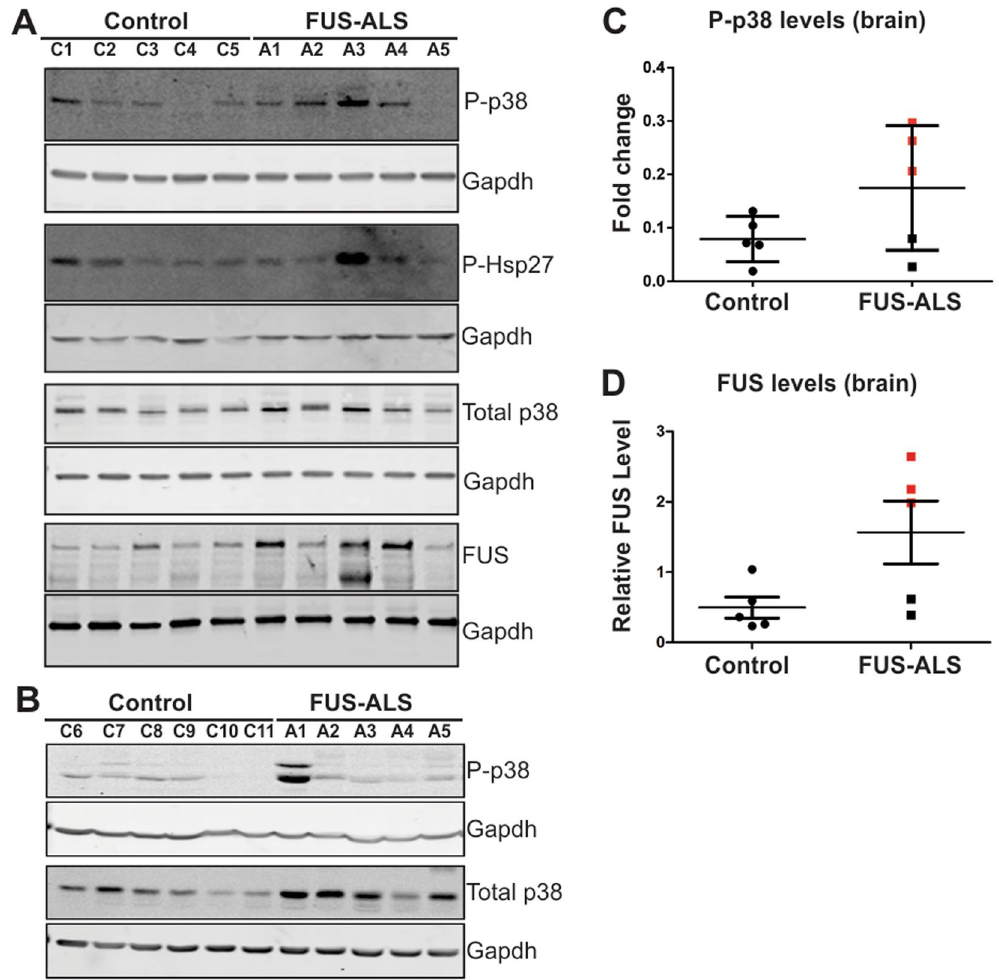
Figure 5. Increased levels of phosphorylated p38 MAPK in human post-mortem CNS tissues derived from individuals with ALS-FUS. Immunoblot analysis of frozen post-mortem brain ( A ) and spinal cord ( B ) tissues derived from non-disease control (C1-C11) and ALS individuals harboring FUS mutations (A1-R521G; A2- H517Q; A3- ex14del; A4-P525L and A5- bp1408del) with the indicated antibodies (see Supplemental Table S2 for detailed patient information). ( C ) Quantification of phosphorylated (active) p38 (p-p38) by immunoblot analysis revealed higher levels of p-p38 MAPK in ALS cases (cases with levels above the control mean are indicated by red squares), compared to control cases. P-p38 values were normalized to total p38 levels. ( D ) Quantification of FUS levels in brain normalized to Gapdh. ALS cases with FUS levels above the control mean are indicated by red squares. ( C , D ) Although, there appears to be a trend in the data, differences between ALS cases and controls did not reach statistical significance due to the small sample size and inherent variability of human postmortem